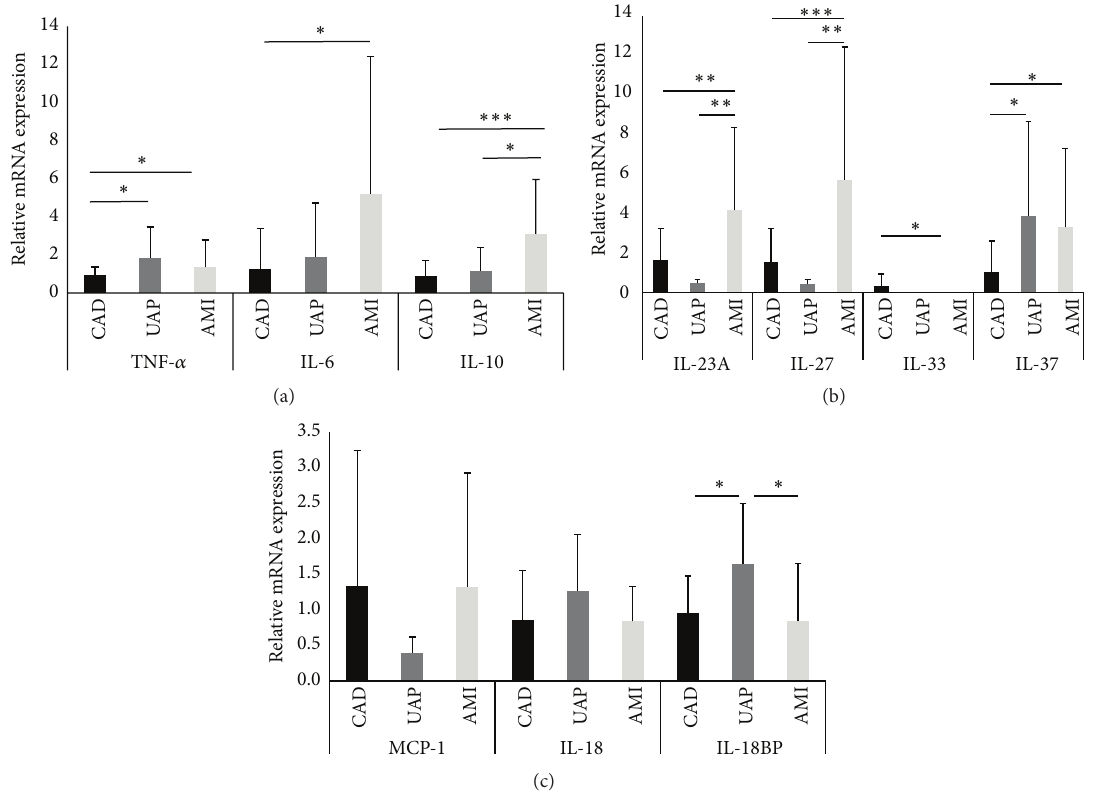
Figure 2: The data are presented as means ± SD. Profile of the expression levels of tumor necrosis factor- 𝛼 (TNF- 𝛼 ), interleukin- (IL-) 6, and IL-10 (a); IL-23A, IL-27, IL-33, and IL-37 (b); and monocyte chemoattractant protein-1 (MCP-1), IL-18, and IL-18 binding protein (BP) (c) in the coronary artery disease (CAD), unstable angina pectoris (UAP), and acute myocardial infarction (AMI) groups. ∗ 𝑃 < 0.05 ; ∗∗ 𝑃 < 0.01 ; ∗∗∗ 𝑃 < 0.001 .